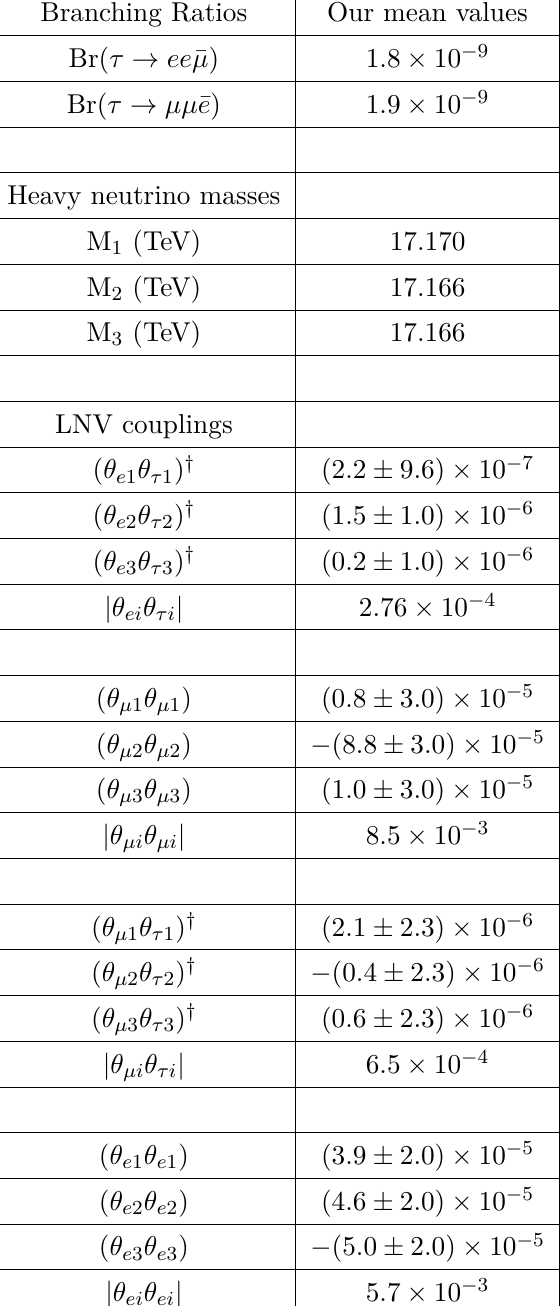
Table 3 . Mean values for the free parameters and branching ratios in the wrong sign processes considering Majorana neutrinos in the LHT. Statistical errors which are not shown are smaller than the last significant figure. We recall the 90% C.L. limits [6]: 1 . 5 × 10 − 8 (on Br( τ → ee ¯ µ ) ) and 1 . 7 × 10 − 8 (on Br( τ → µµ ¯ e )